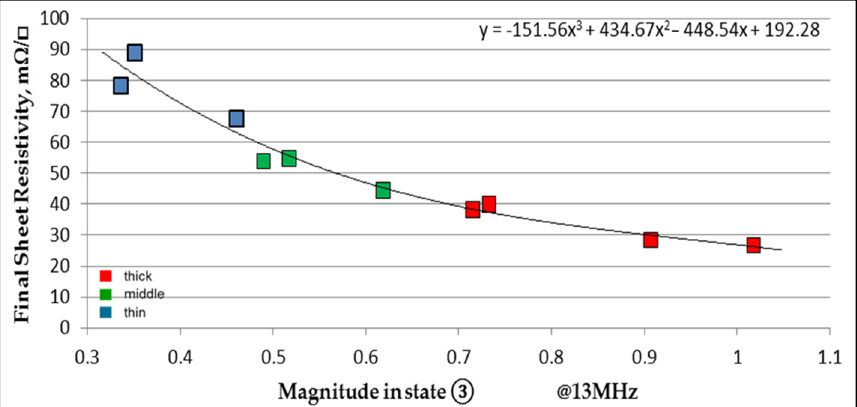
Figure 16. Correlations between the final sheet resistivity and the magnitude in state (3) at a frequency of 13 MHz for Cu/Ag films on CFRP substrate with coated area of 4 cm × 4 cm.